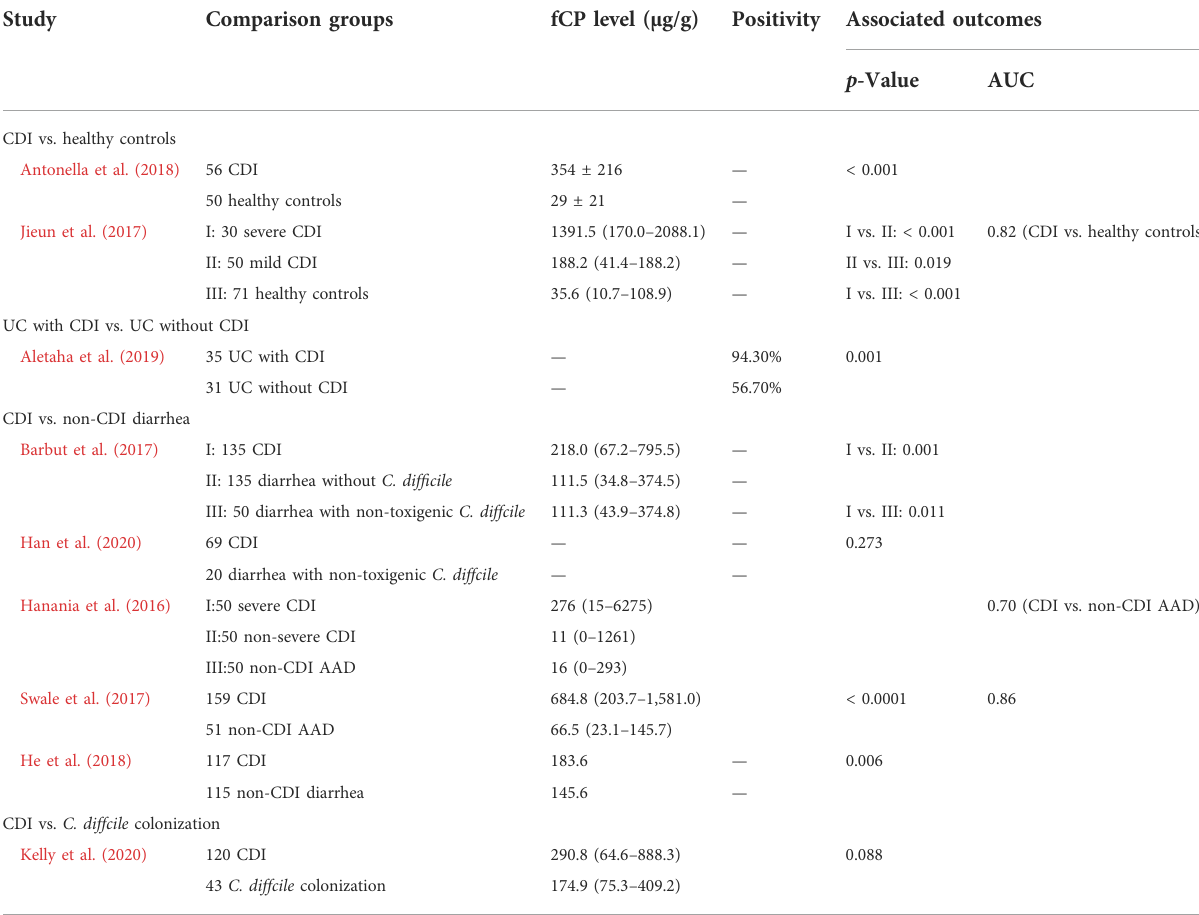
TABLE 4 Main results of fCP in distinguishing patients with CDI from other